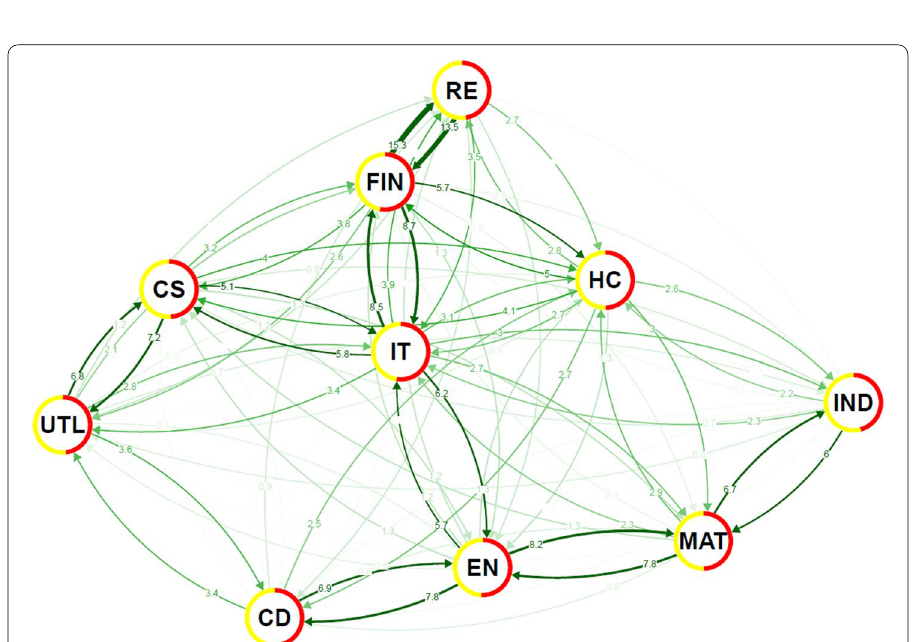
Fig. 4 DY spillover based on conditional median: least absolute deviations (LAD) estimator. Note. See notes to Fig.